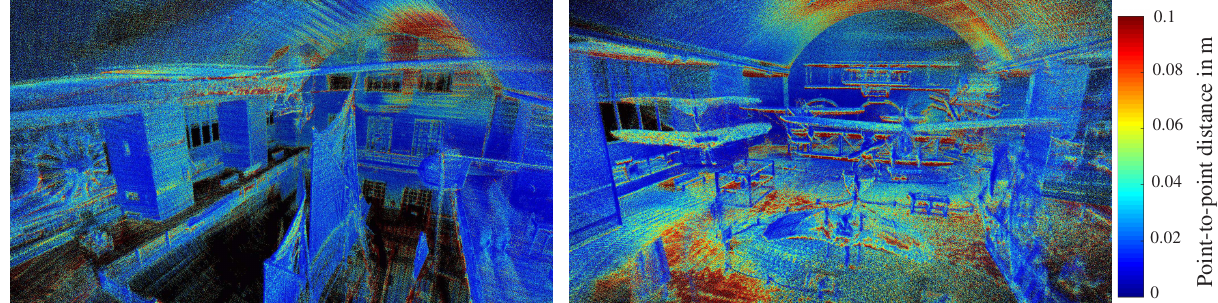
Figure 5: Visualization of the changes in the point cloud. Shown are two views of the optimized 3D point cloud, colored with the difference to the result from Google’s